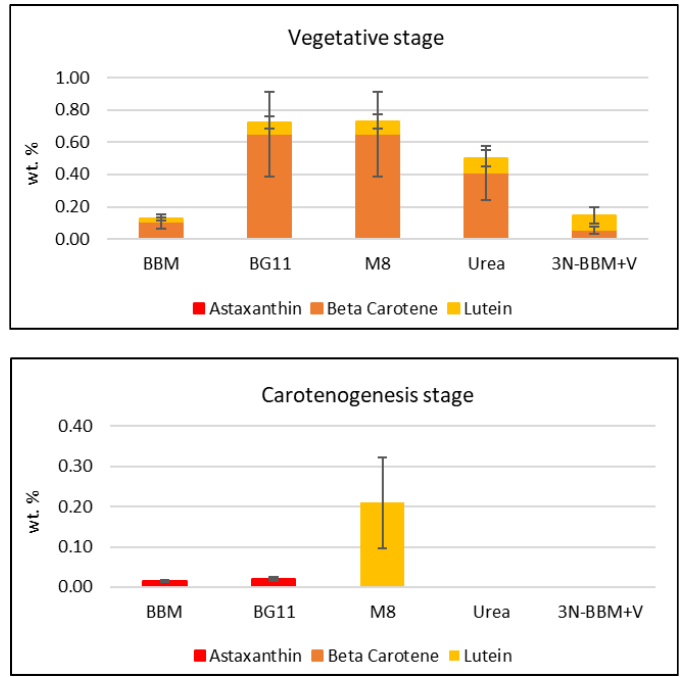
Figure 6. Carotenoids produced by Coelastrella sp. in the initial screening of 5 standard media in the vegetative stage (after 12 days) and the carotenogenesis stage (after an additional 24 days). Error bars represent the coefficient of variation.